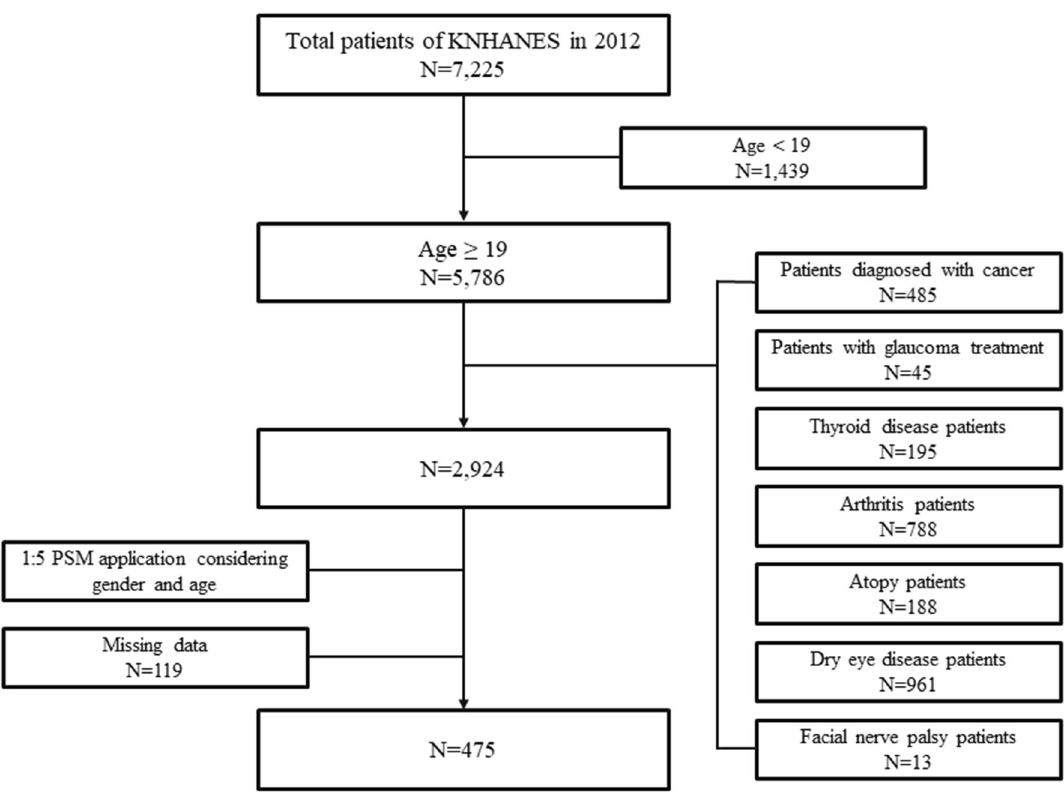
Figure 1. General population selection flow diagram for comparison of lipid profile between MGD and control patients.